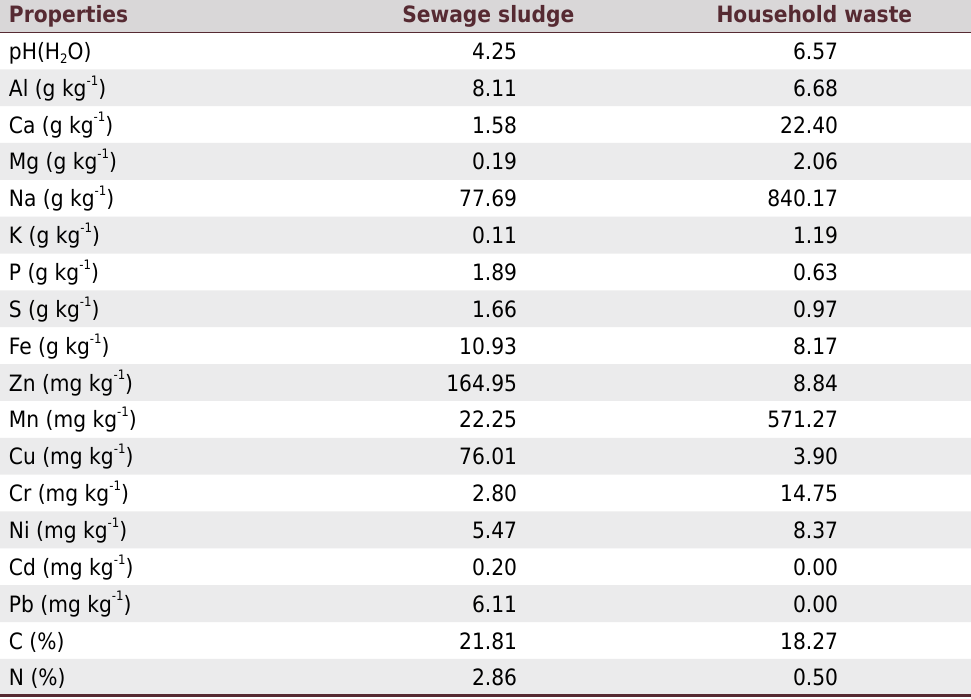
Table 2. Chemical properties of sewage sludge and household waste composting